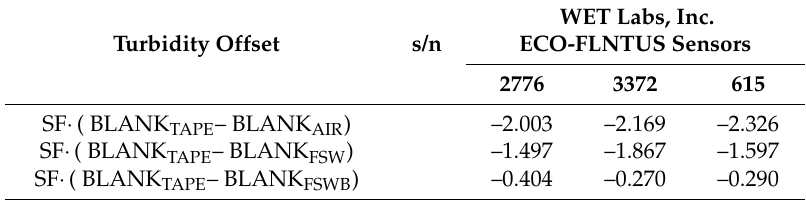
Table 2. Difference of turbidity concentration in NTU unit computed using different BLANK values (air, filtered sea water without and with a black rubber shield) with respect to using BLANK value obtained with the detector covered by the black